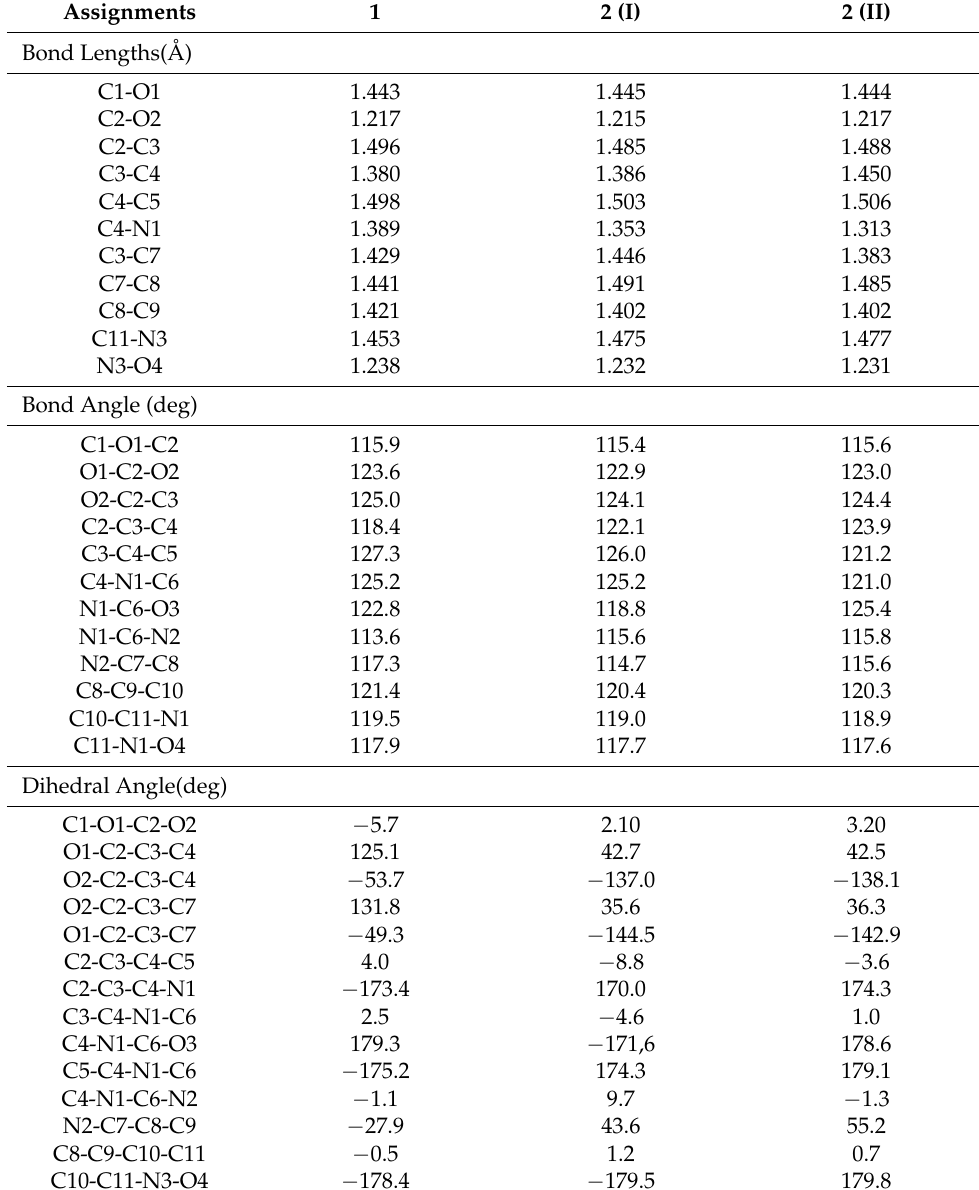
Table 5. Geometric parameters of the compounds calculated at the B3LYP/6-31+G(d,p) level. Assignments